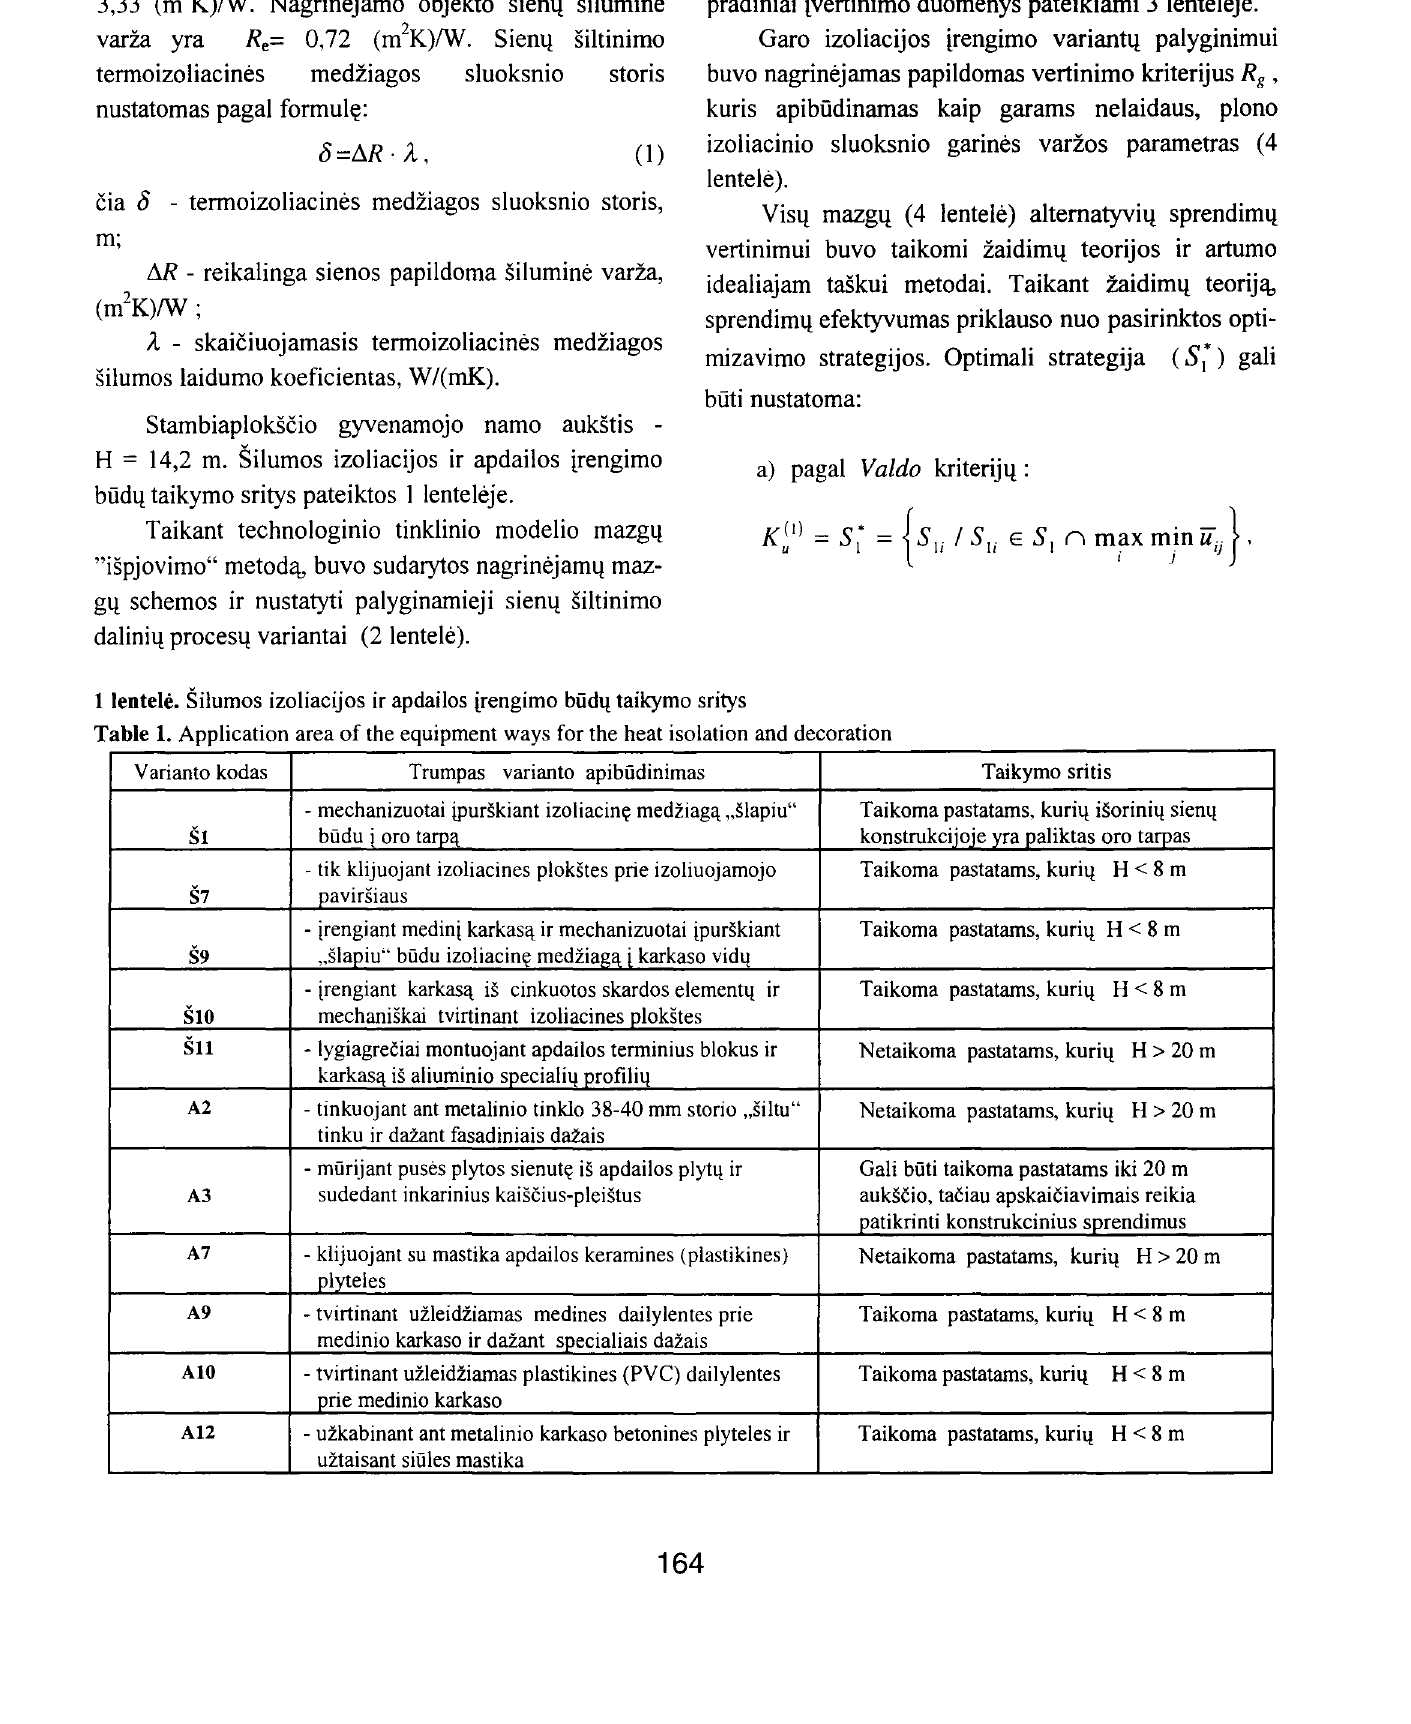
Table 1. Application area of the equipment ways for the heat isolation and decoration Yarianto